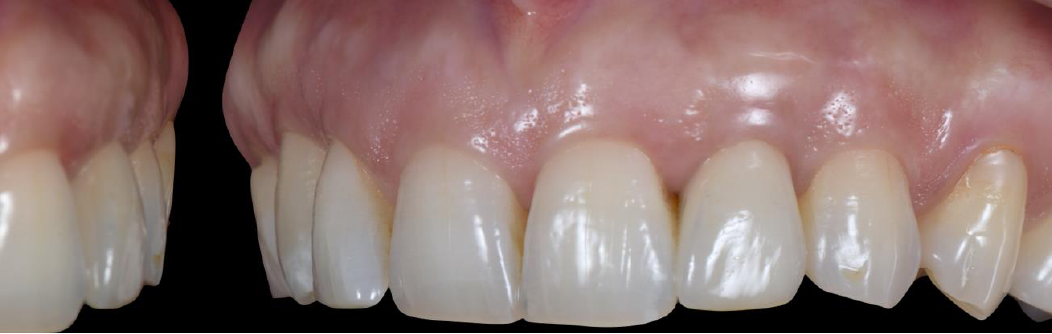
Figure 27. Clinical image. One year post loading.